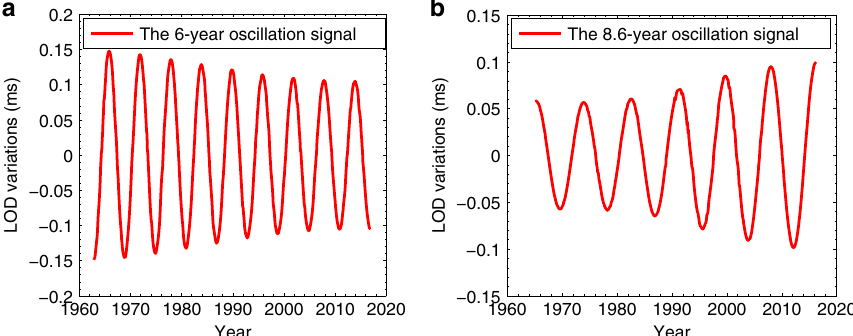
Fig. 2 The 6-year and 8.6-year signals in time domain recovered by this work. a Con fi rms that the 6-year oscillation is a decaying oscillation 13 with an observed quality factor ~51 (i.e., the currently observed decaying rate is about 8.4 × 10 − 4 /month); b shows that the 8.6-year signal presents an increasing phenomenon. Here, the phase information of these two signals is recovered accurately from the simulation analysis (Supplementary Figs. 2, 3, 9, 14